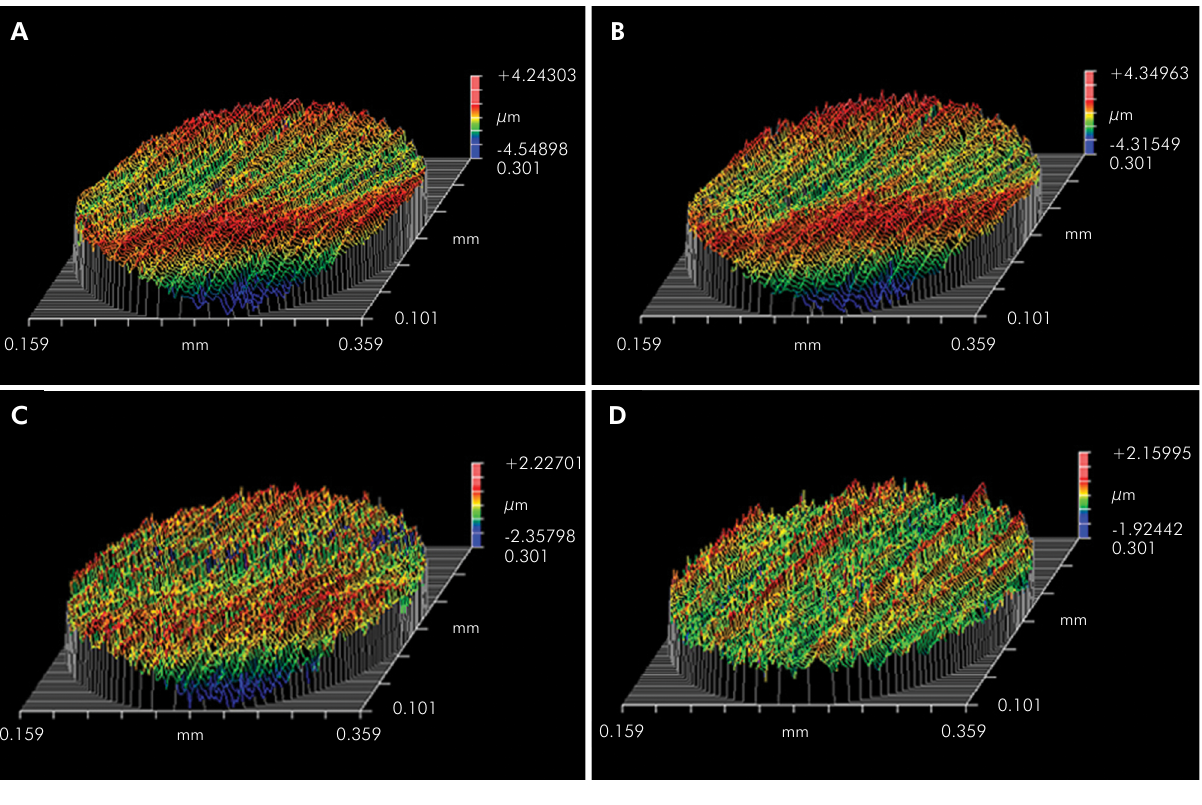
Figure 3. Instrument surface morphology obtained by interferometry. (A) new, unused instrument; (B) once-used instrument; (C) instrument used twice; and (D) instrument used three